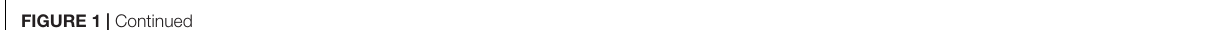
TABLE 1 | Material studied in this work including their taxonomic and morphological identity, geographical provenance and N observed. Section